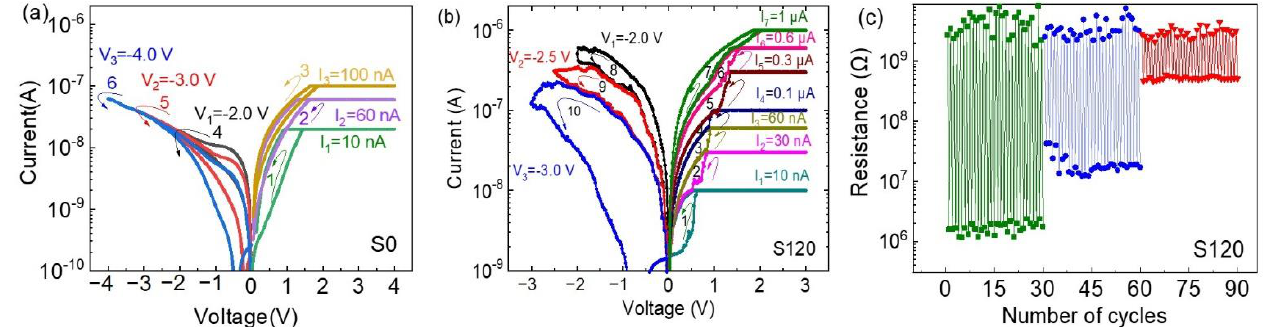
Figure 4. Multilevel properties of devices ( a ) without and ( b ) with copper nanoparticles; ( c ) Voltage- pulse-stimulated endurance cycling for 30 cycles per state of device S120.